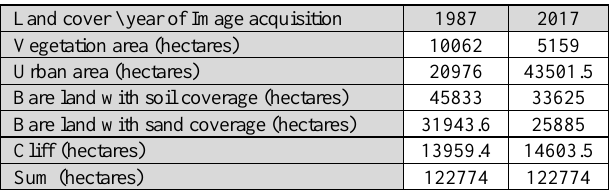
Table 7. Satellite image classification results